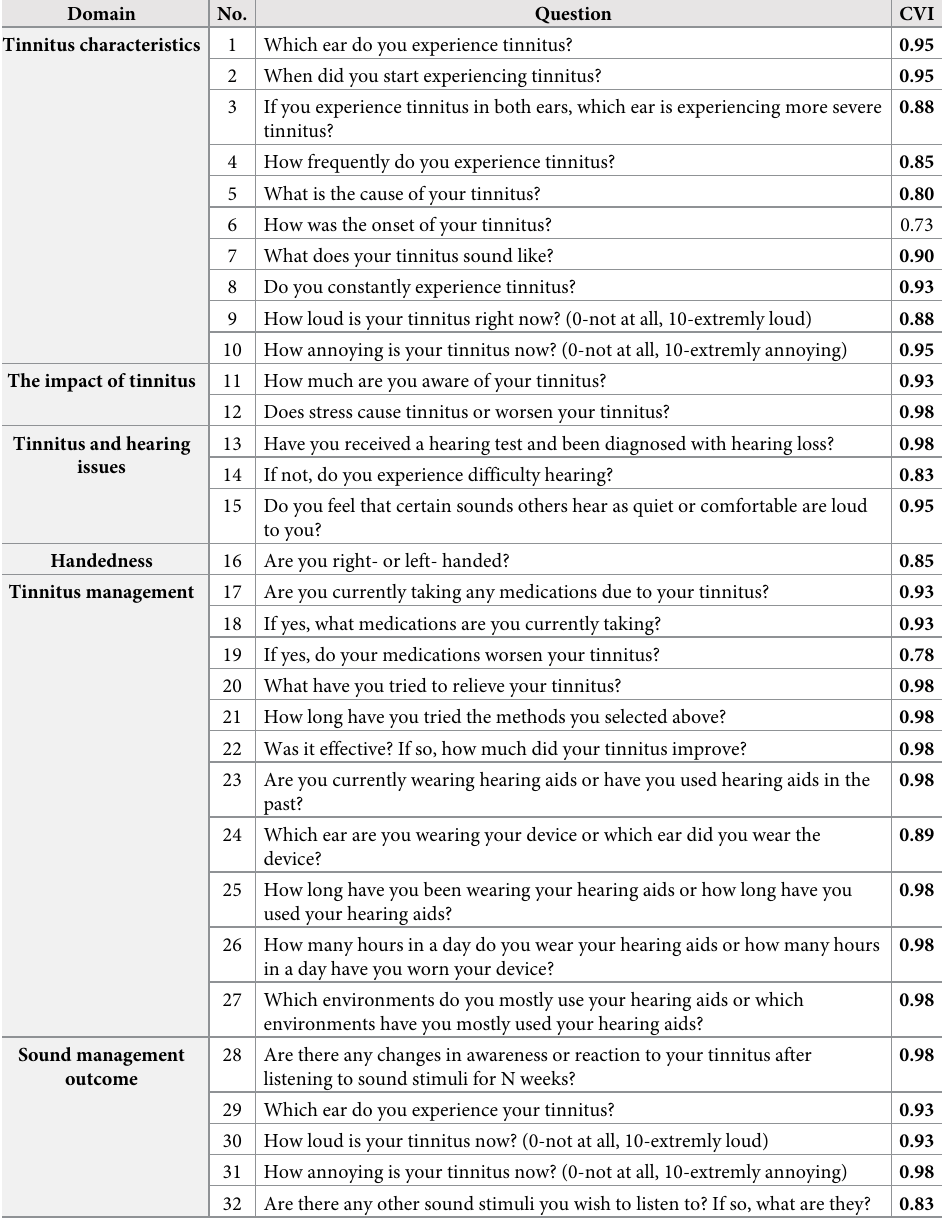
Table 2. Tinnitus outcome questionnaire for sound management and CVIs for each